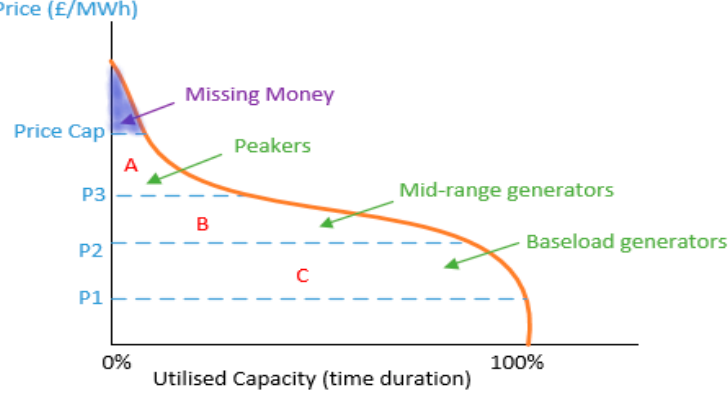
Figure 1. The missing money problem for generators in energy-only markets.